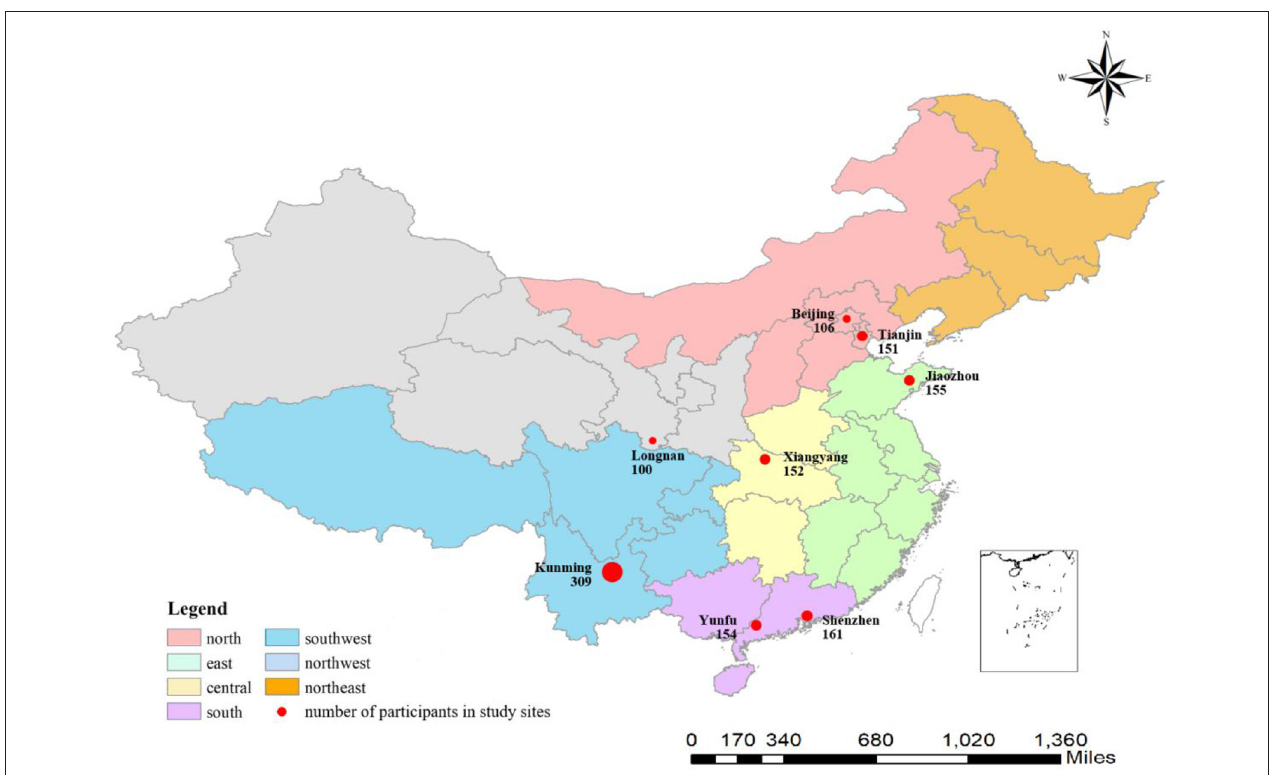
FIGURE 1 | Participants geographic distribution.